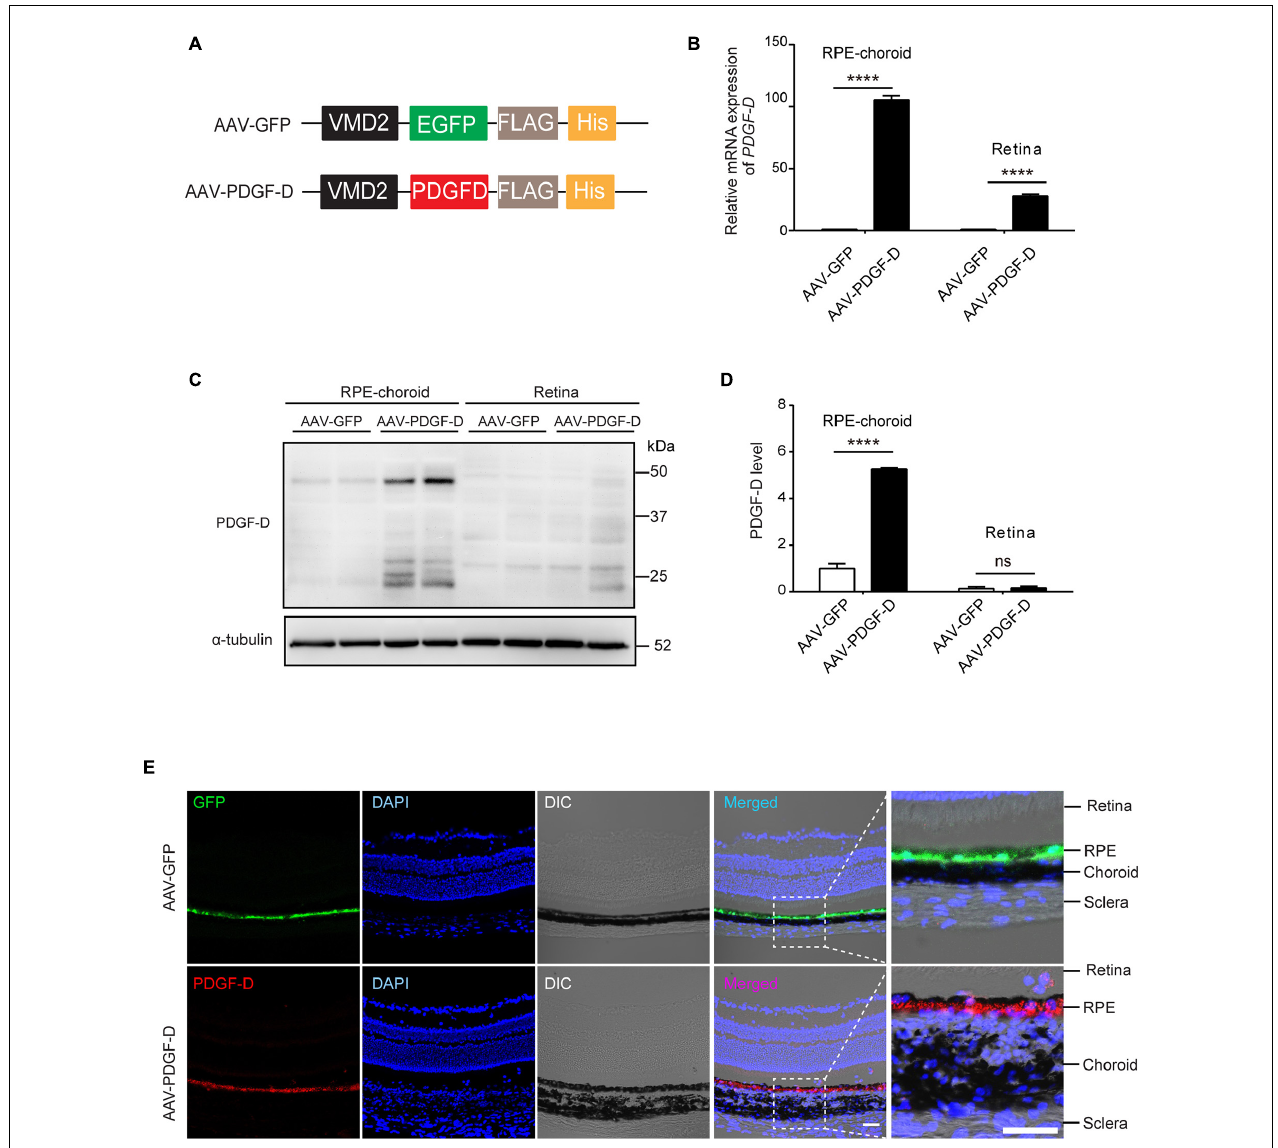
FIGURE 2 | RPE-specific overexpression of PDGF-D in vivo. (A) Schematic diagram illustrating the AAV vector carrying GFP (AAV-GFP) or human PDGF-D (AAV-PDGF-D) gene and RPE specific VDM2 promoter. (B) Real-time PCR results of relative mRNA expression of PDGF-D in retinae or RPE-choroid complex from mice injected with AAV-GFP or AAV-PDGF- D for 4 weeks. (C) Representative immunoblotting showing PDGF-D expression in mouse retinae or RPE-choroid complex. (D) Quantifications of PDGF-D protein levels in (C) . (E) Immunofluorescence images highlighting RPE-specific expression of GFP or PDGF-D in mouse RPE-choroid complex with 4 weeks AAV-GFP or AAV-PDGF-D injection, respectively. Scale bar: 50 µ m. n = 5, **** p < 0.0001, ns: not